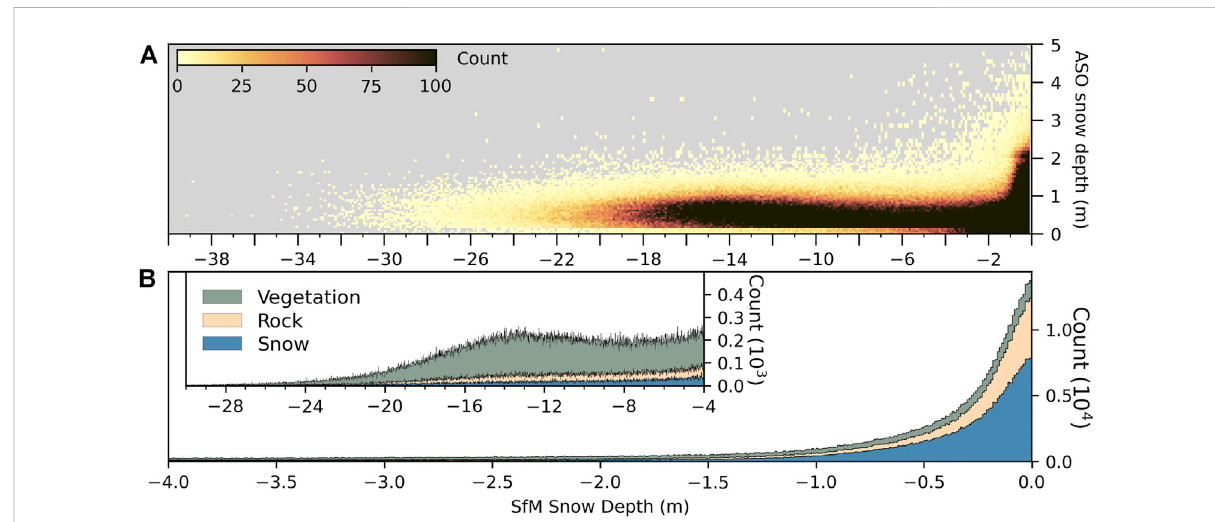
FIGURE 7 Snow depth with negative values by SfM plotted against values by ASO at 3 m resolution. Extreme outliers are dominantly found in areas with snow depth of less than 1 m (A) or vegetated areas (B) . Note the different y-scales for the insert in (B) .